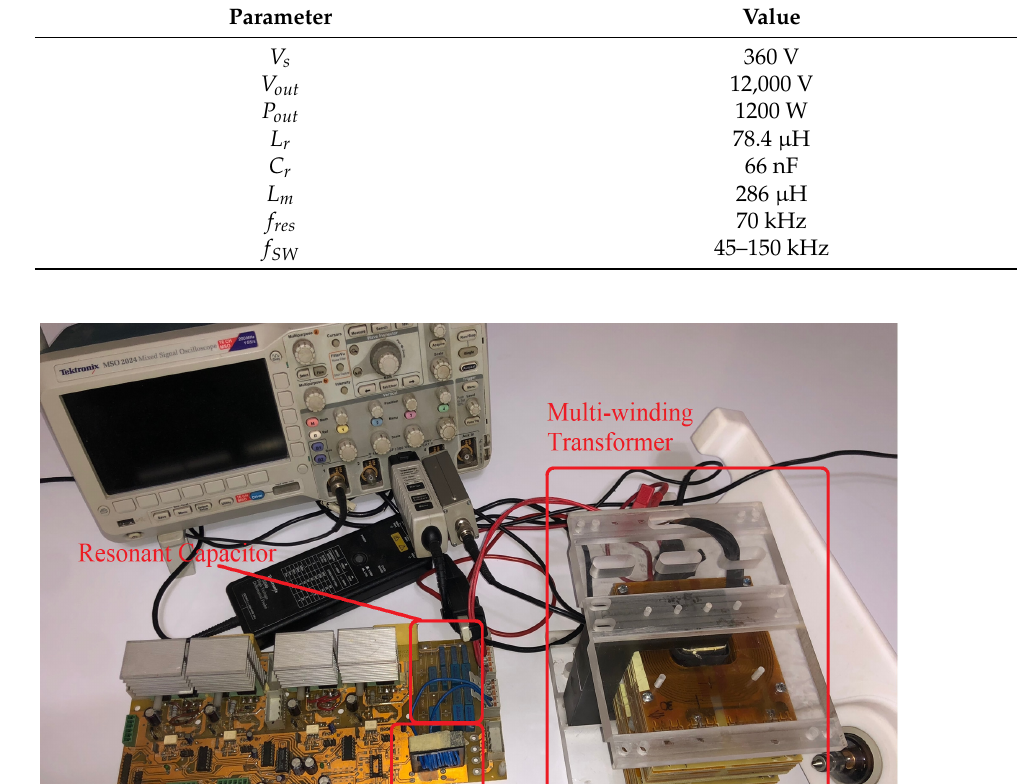
Table 4. LLC resonant converter parameters.